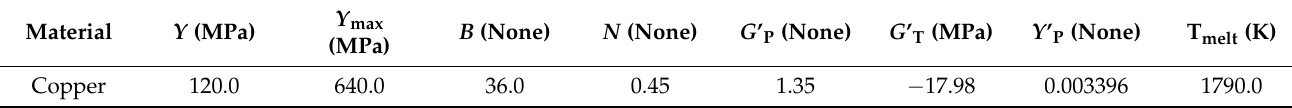
Table 2. Material parameters (Steinberg–Guinan) [2].